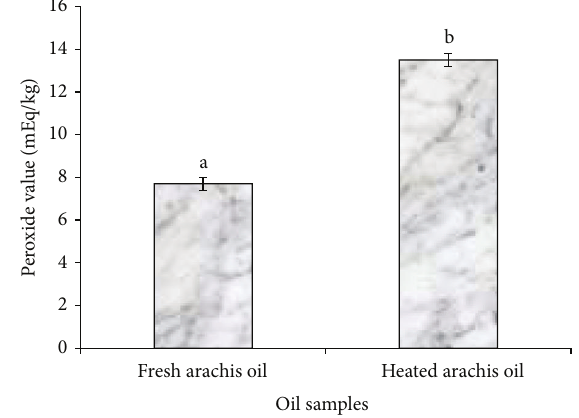
Figure 5: Effect of thermal oxidation on peroxide value of arachis oil. Peroxide values are expressed as mean ± standard deviation ( 𝑛 = 3 ). Bars with different alphabets are significantly different ( 𝑃 < 0.05